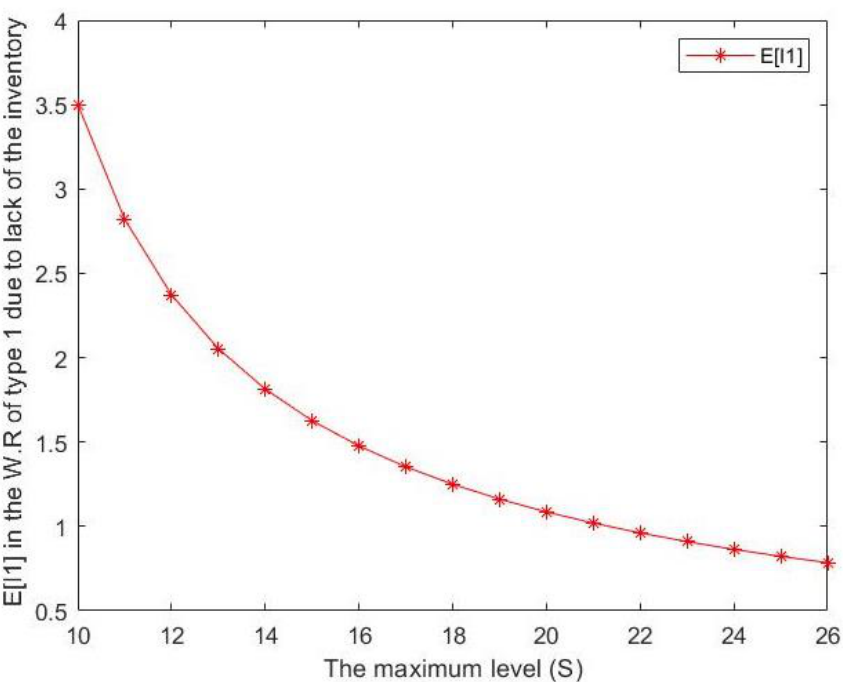
Figure 5. Effect of S on expected number of type 1 customers in the waiting room for type 1 due to lack of inventory.